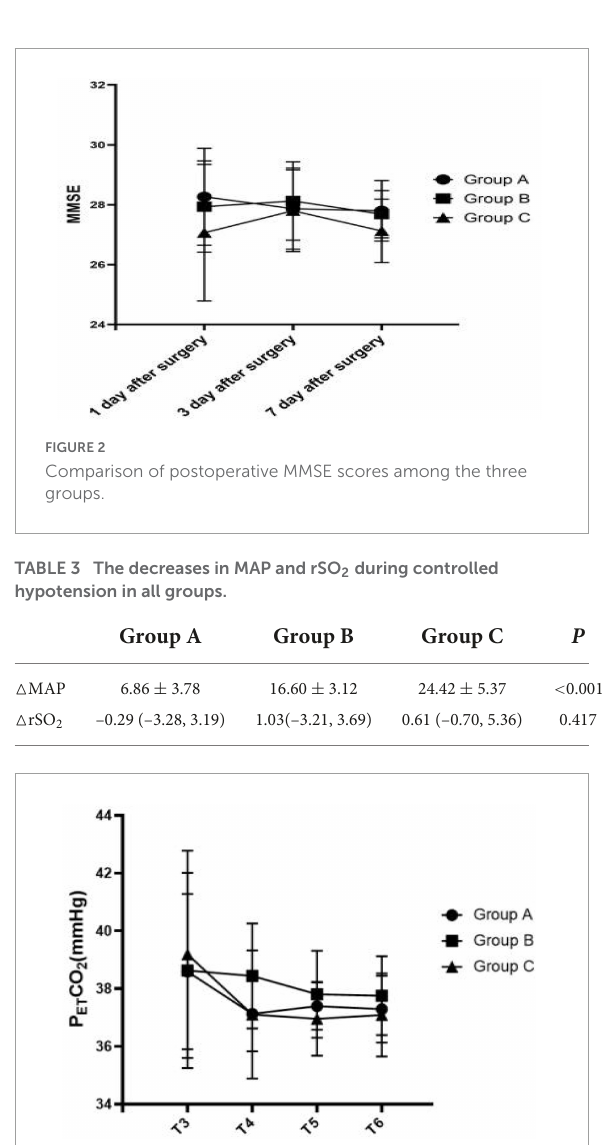
FIGURE3 Comparison of P KT CO 2 at various time points among the three groups.